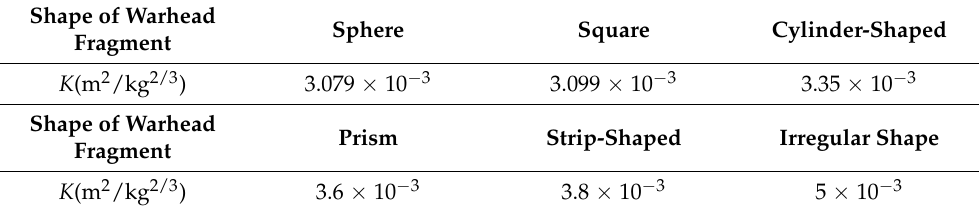
Table 1. Shape coefficient of each shape of warhead fragment. Shape of